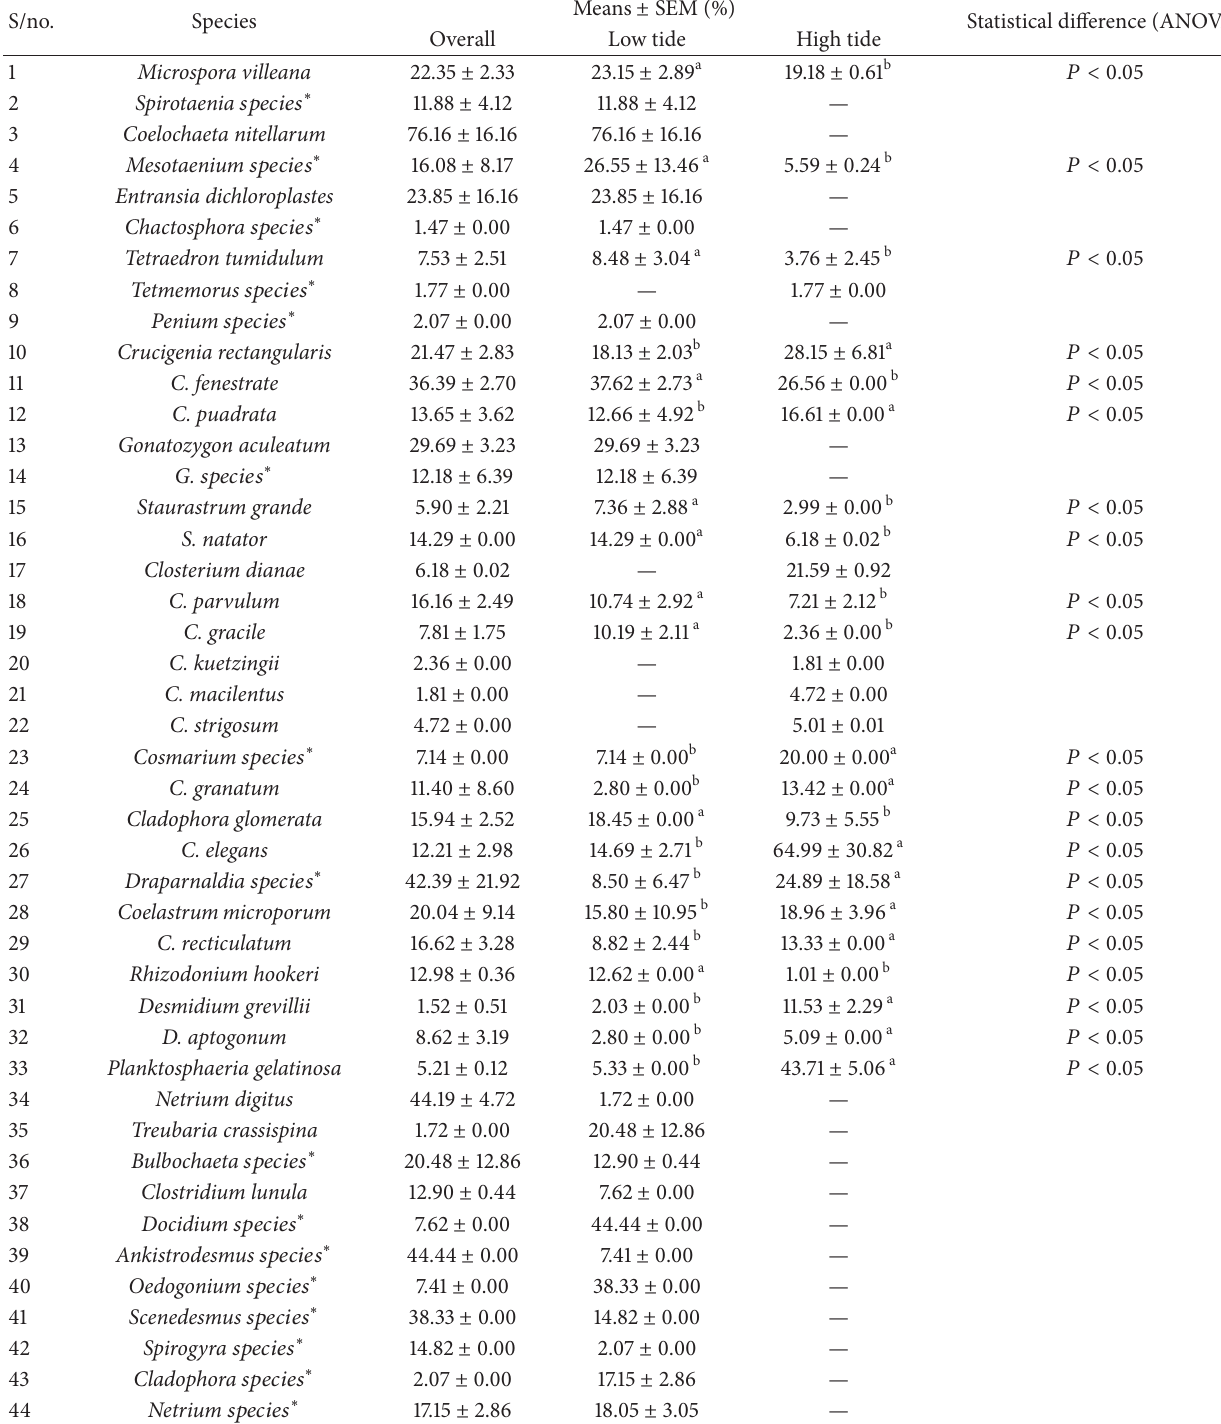
Table 5: Variations of Chlorophyceae species under tidal influence in Okpoka